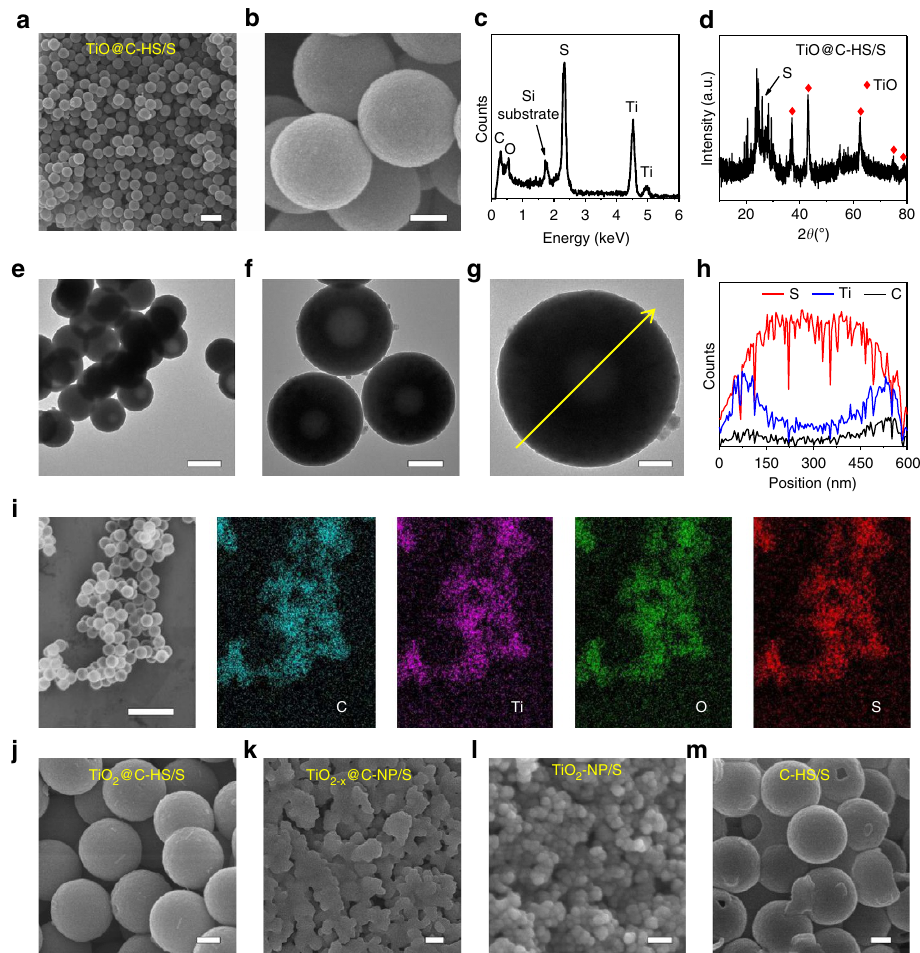
Figure 4 | Characterization of the sulfur-based composite materials. ( a , b ) SEM image, ( c ) EDX spectrum, ( d ) X-ray diffraction pattern, ( e – g ) TEM images, ( h ) linear distributions of S, Ti and C along the arrow line on g , and ( i ) EDX mapping area and corresponding elemental distributions of C, Ti, O and S of TiO@C-HS/S. SEM images of ( j ) TiO 2 @C-HS/S, ( k ) TiO 2 (cid:2) x @C-NP/S, ( l ) TiO 2 -NP/S and ( m ) C-HS/S. Scale bars, 1 m m ( a ), scale bars, 200nm ( b , f , j , k , m ), scale bars, 500nm ( e ), scale bars, 100nm ( g , l ), scale bars, 2 m m ( i